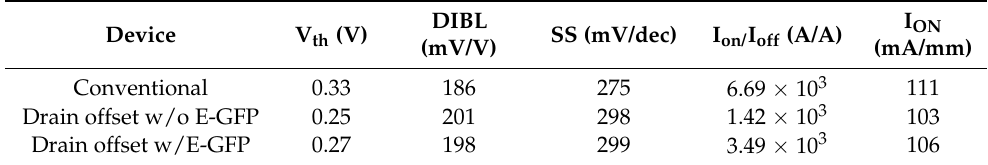
Table 3. Electrical parameters of the JL FinTFTs with various structures after PMA in FG at 400 ◦ C for 300 s.